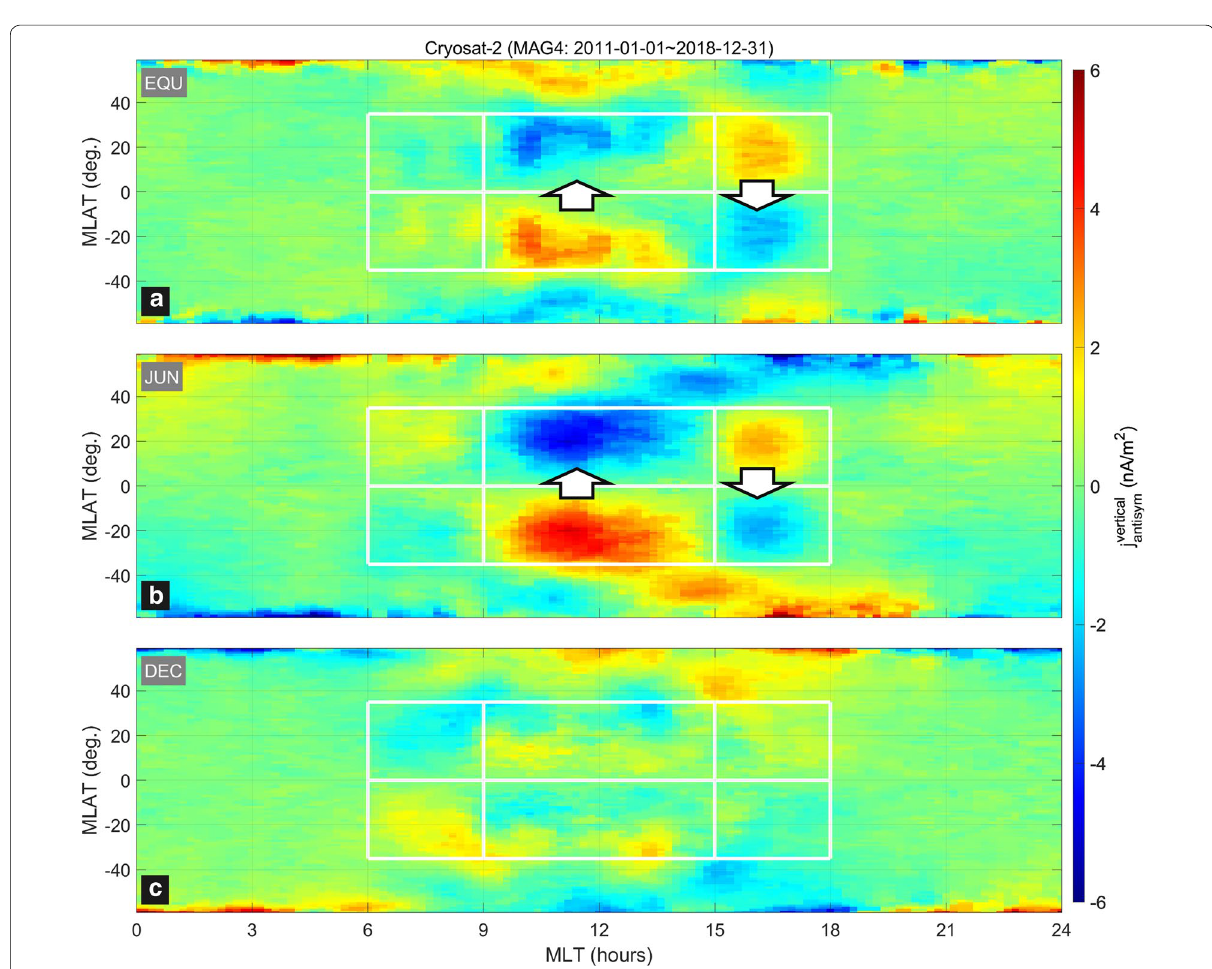
Fig. 2 Hemispherically anti-symmetric components of vertical current density (i.e., IHFACs) from CryoSat-2 as a function of MLT (abscissa) and MLAT (ordinate). From top to bottom, respective panels represent combined equinoxes, June solstice, and December solstice. The ‘MAG4 ′ in the figure title signifies a combined solution of B-field from the three magnetometers onboard